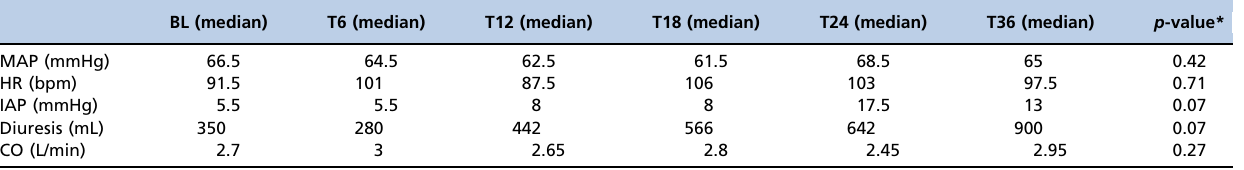
Table 2 - Hemodynamic variables of animals submitted to peritoneal lavage with PDS. BL (median)